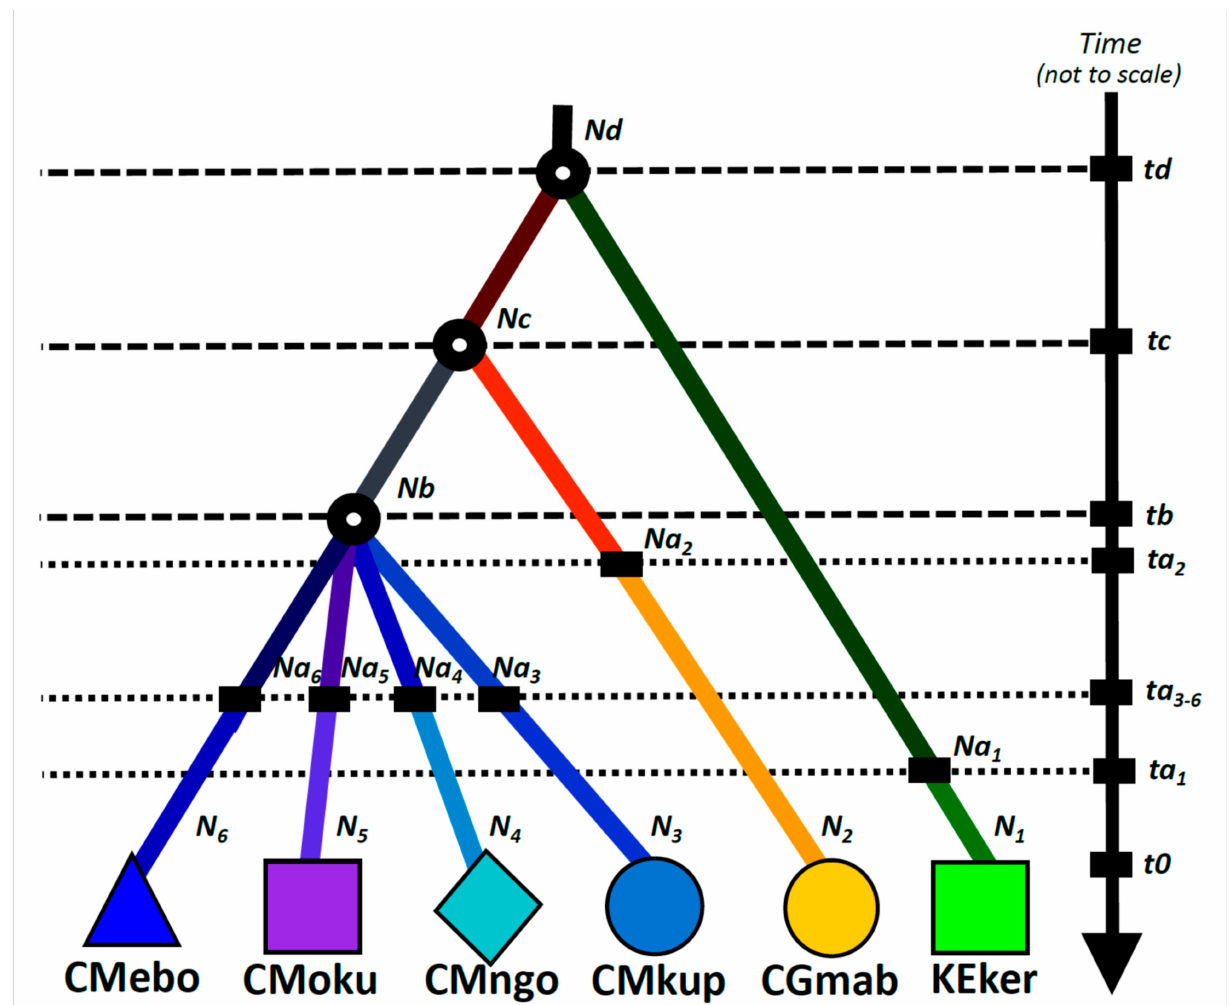
Figure 5. Most likely scenario retained for inferring the demographic history of populations of P. latifolius in Kenya (KE), the Republic of the Congo (CG), and Cameroon (CM). Prior and posterior of each parameter (effective sizes N 1 – N 6 , Na 1 – Na 6 , Nb , Nc , Nd , and time intervals ta , ta 1 , ta 6 , tb , tc , td ) are detailed in Table